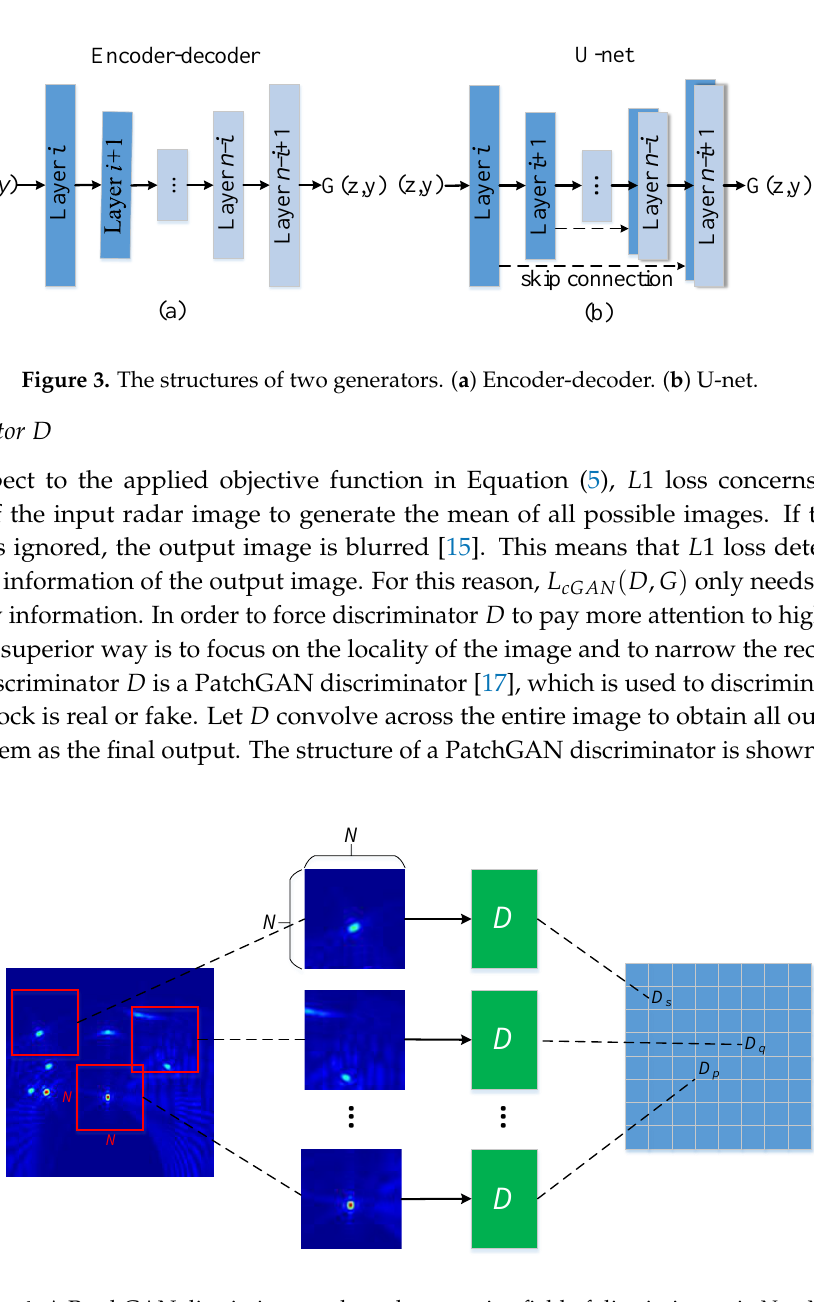
Figure 4. A PatchGAN discriminator where the receptive field of discriminator is N × N